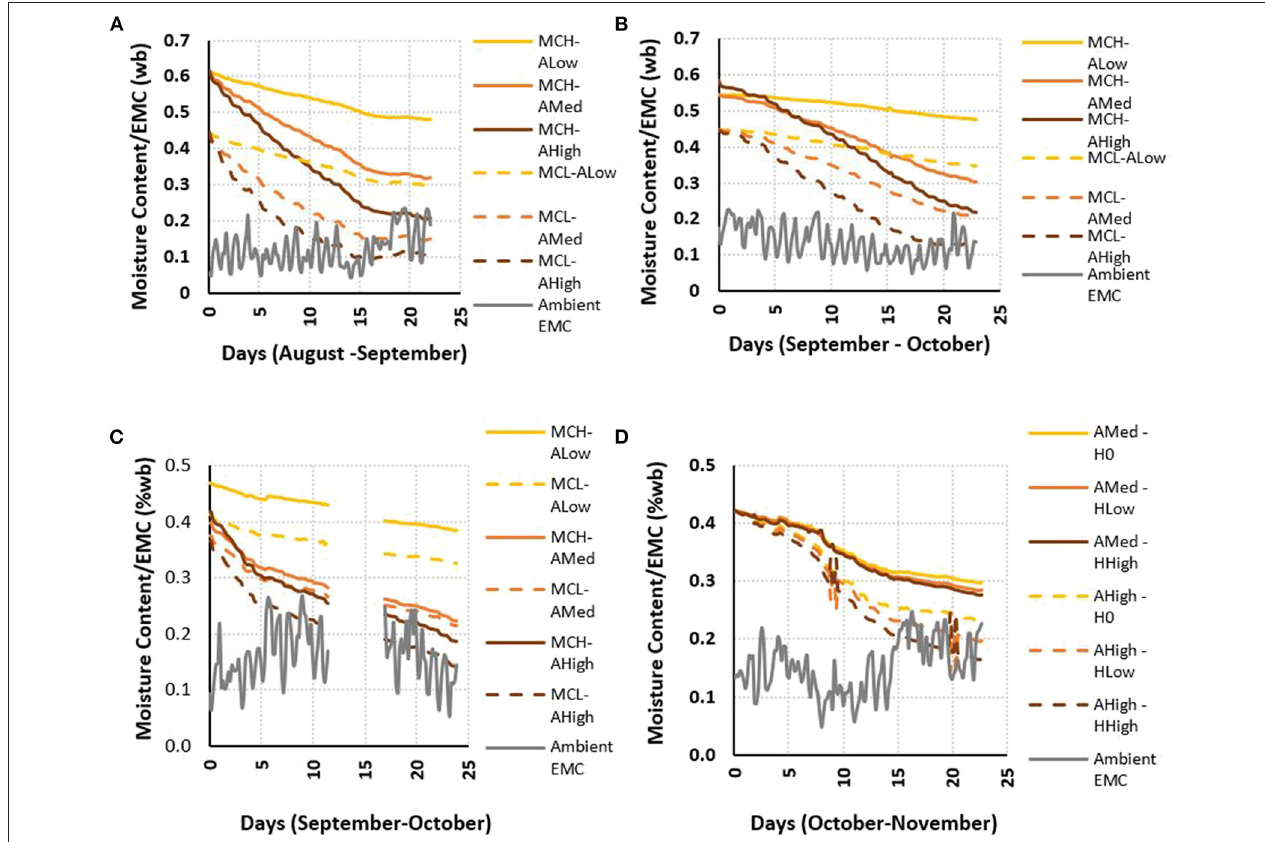
FIGURE 4 | Average biomass drying performance over time for each feedstock material/ trial compared with local ambient equilibrium moisture content (EMC): (A) hog fuel, (B) sawmill woodchips, (C) bark without supplemental heat, and (D) bark with supplemental heat (MC L / H , low/high moisture content; A Low / Med / High , low/medium/high airflow; H 0 / Low / High , no/low/high heat